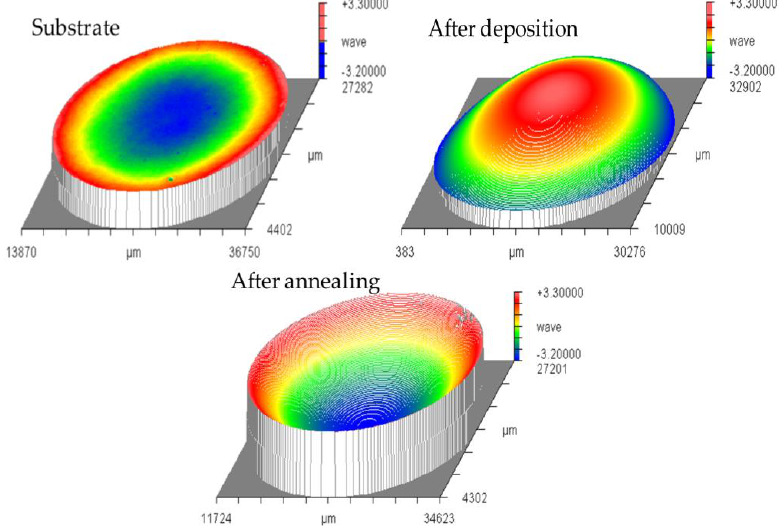
Figure 4. Surface figure of Ta 2 O 5 film on fused silica before deposition (substrate), after deposition (as-deposited), and after annealing treatment (annealed at 773 K). (as-deposited), and after annealing treatment (annealed at 773